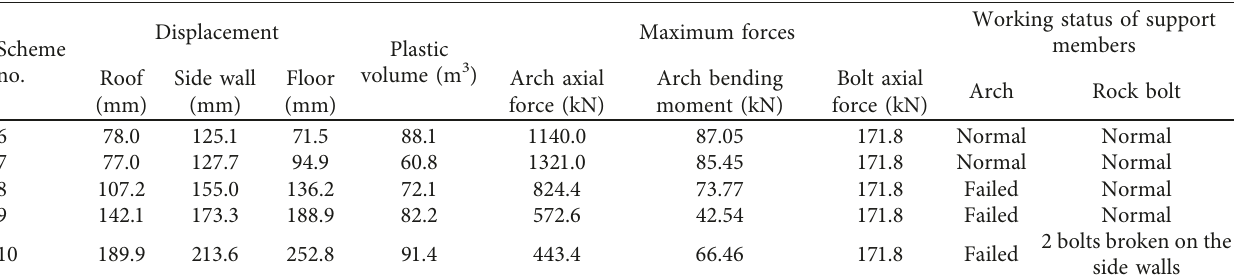
Figure 6: Variation curves of displacements and plastic zone volumes with lateral ground stress. (The results of Scheme 5 (ground stress 20MPa) are not shown in the curves because of an interruption in the calculation.) Table 5: Main results of Schemes 6–10 (time